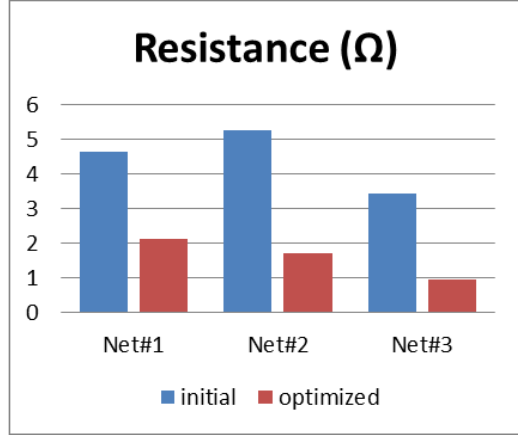
Figure 6. Wire resistance reduction.